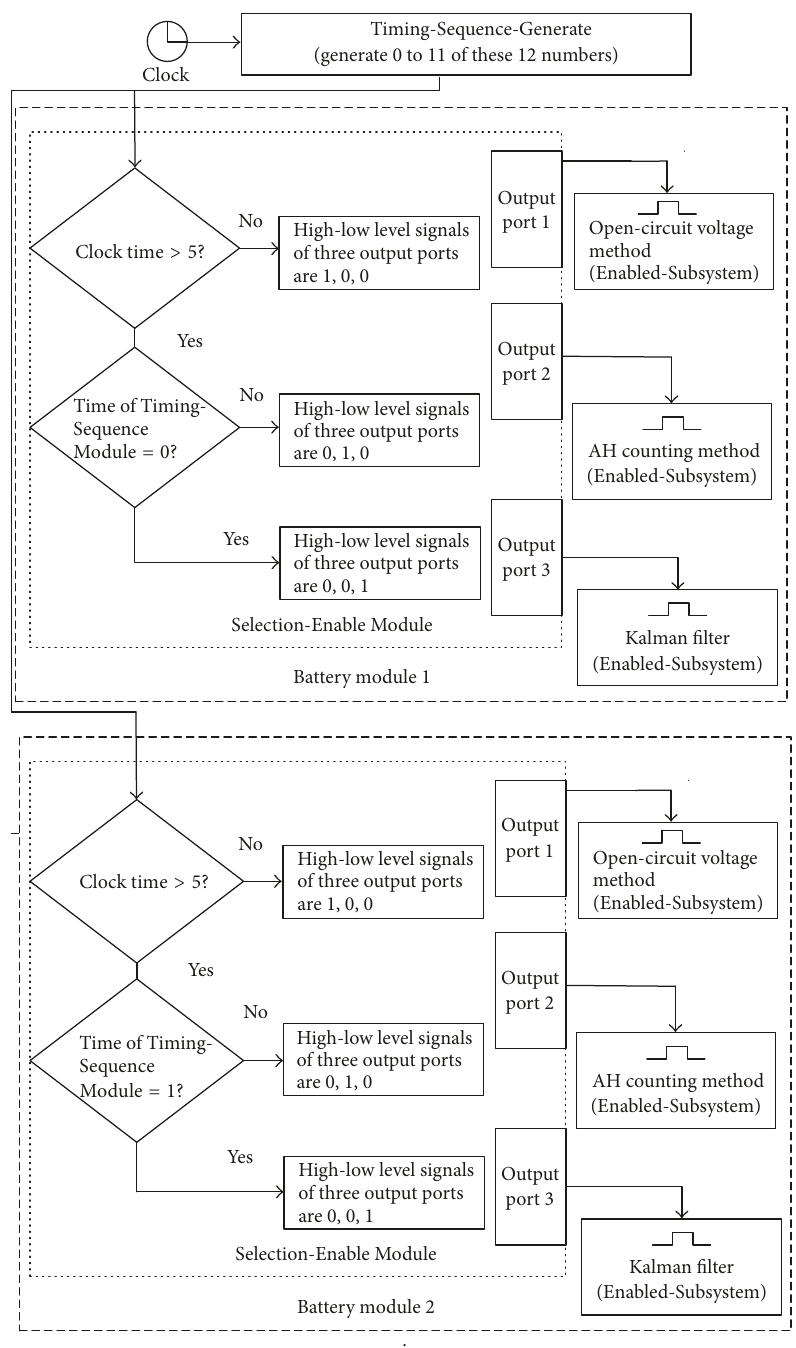
Figure 8: Timing-Sequence